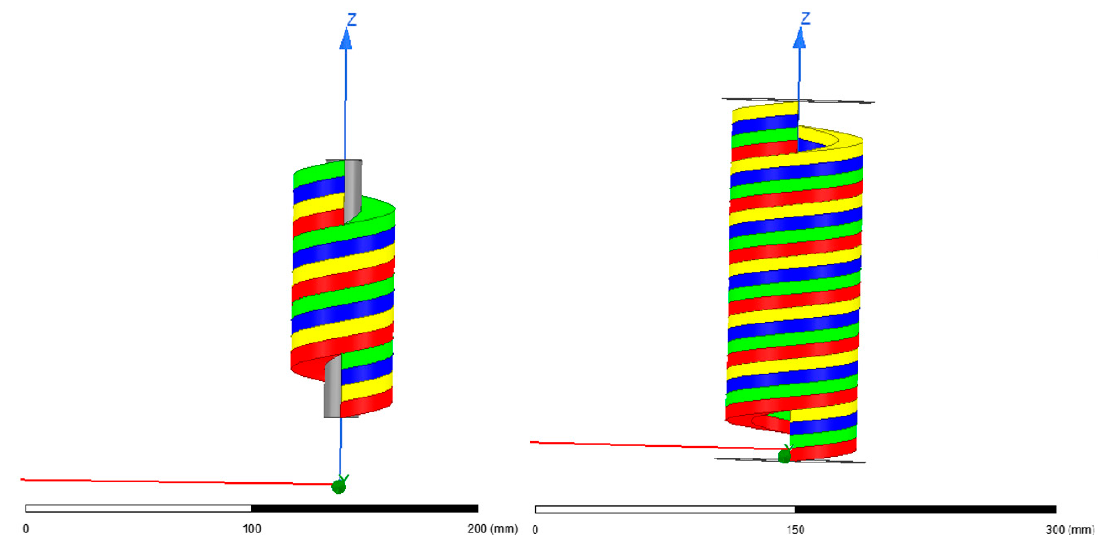
Figure 12. 3D Model of the Shaft (left) and the Ring (Right).